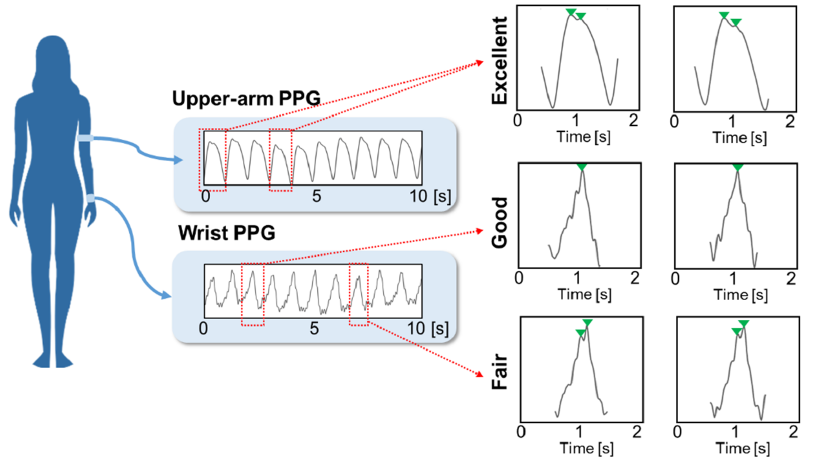
Figure 6. Representative PPG signals measured at the upper arm and wrist, respectively, and compared with classifications as fair, good, and excellent in terms of signal quality. These PPG signals can be simultaneously obtained from various body locations. At the excellent level, the systolic peak and diastolic peak (green triangle upside down) can be clearly detected, and the amplitude of the diastolic peak is lower than the amplitude of the systolic peak. At the good level, only one peak, similar to the systolic peak, can be detected. At the fair level, the PPG signal contains some noise that may affect peak detection.